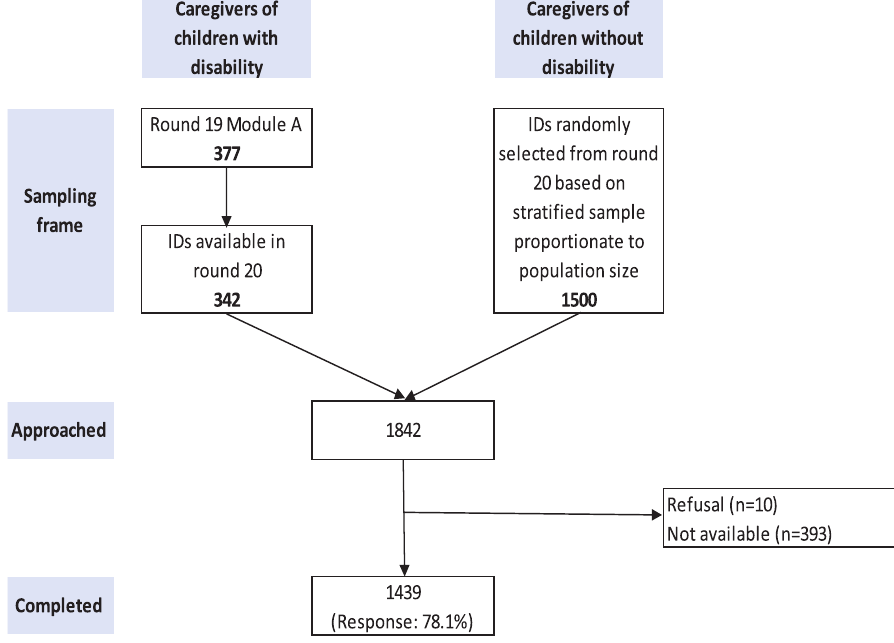
Fig 1. Sampling frame for child disability assessment at the Iganga-Mayuge Health and Demographic Surveillance